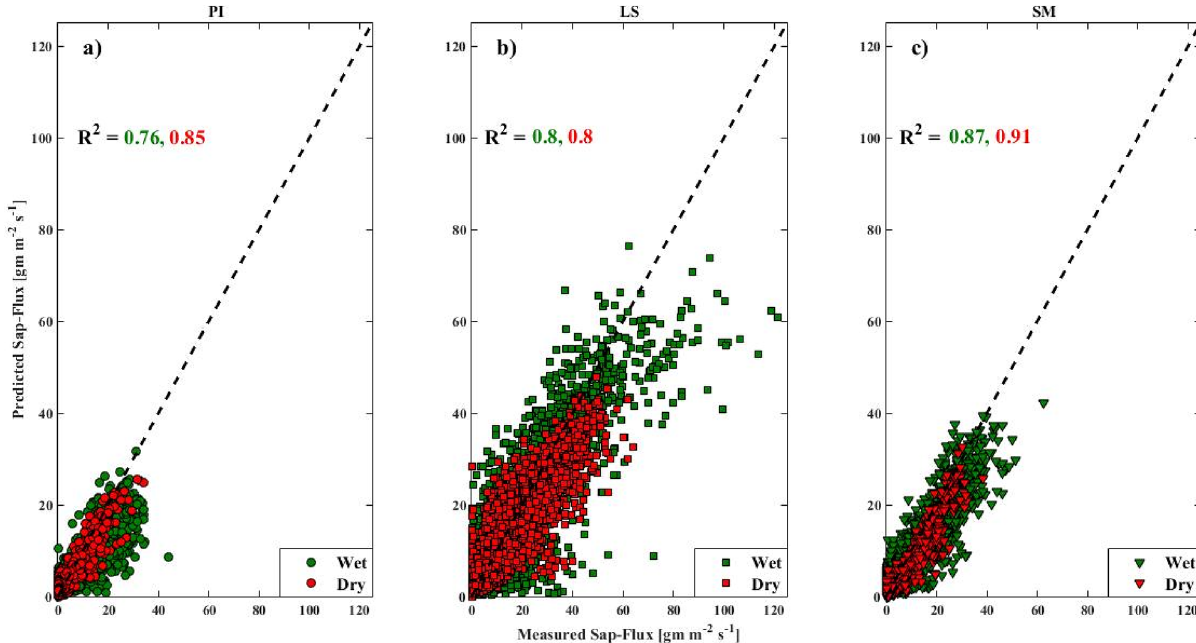
Figure 1. The best model of sap flux density prediction for ( a ) Pterocarpus indicus (PI), ( b ) Lagerstroemia speciosa (LS), and ( c ) Swietenia macrophylla (SM). The green (red) filled circles represent sap flux density data during the wet (dry) season. The corresponding R 2 value for each season is also indicated. The black dashed line is the 1:1 line. This figure was generated using MATLAB version 7.12.0 R2017a (https ://www.mathw orks.com/ produ cts/new_produ cts/relea se201